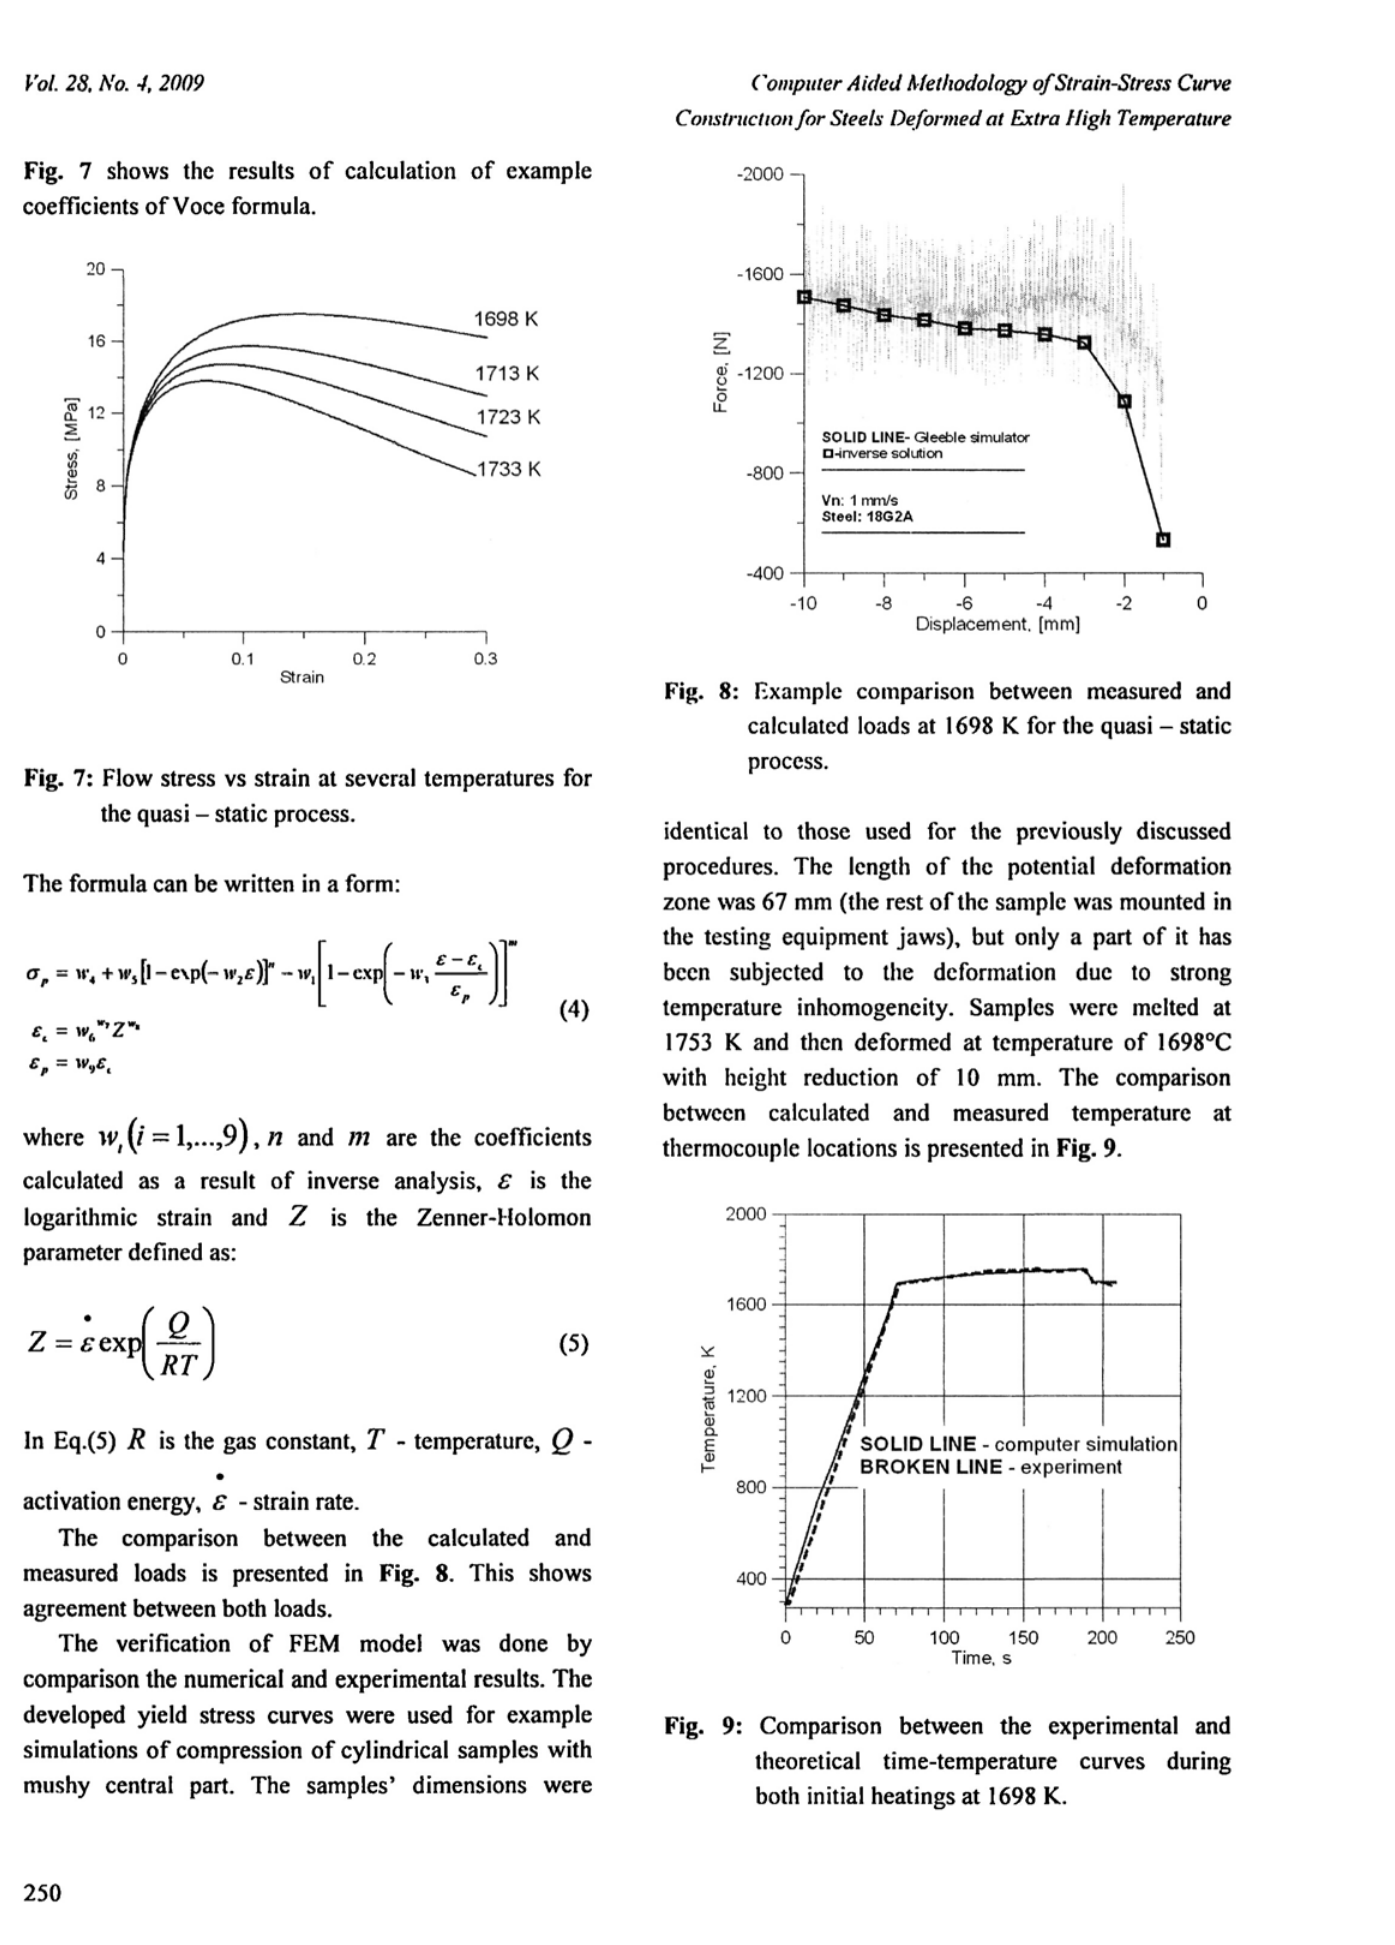
Fig. 9: Comparison between the experimental and theoretical time-temperature curves during both initial heatings at 1698